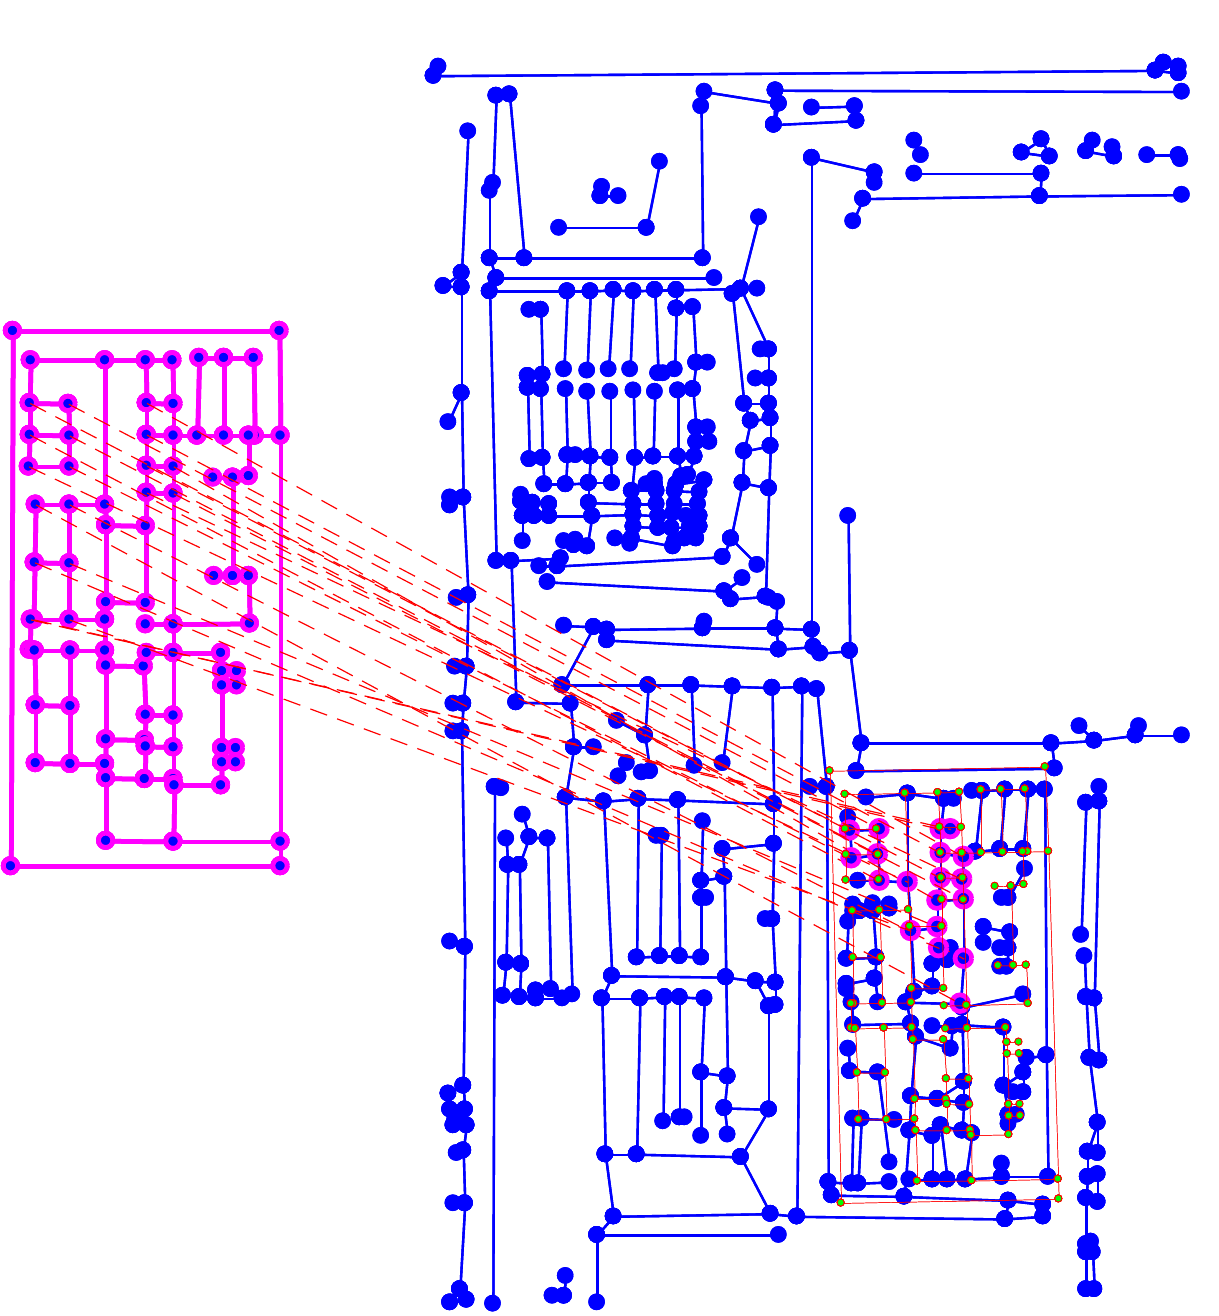
Figure 13. Projection of the template graph ( left ) located in the target graph ( right ). These graphs were created from the images shown in Figure 12. From the matching, only the largest connected sub-graph is kept (highlighted in pink in the target) and used to estimate the template projection. This projection is represented by the graph with green nodes and red edges. S tot =